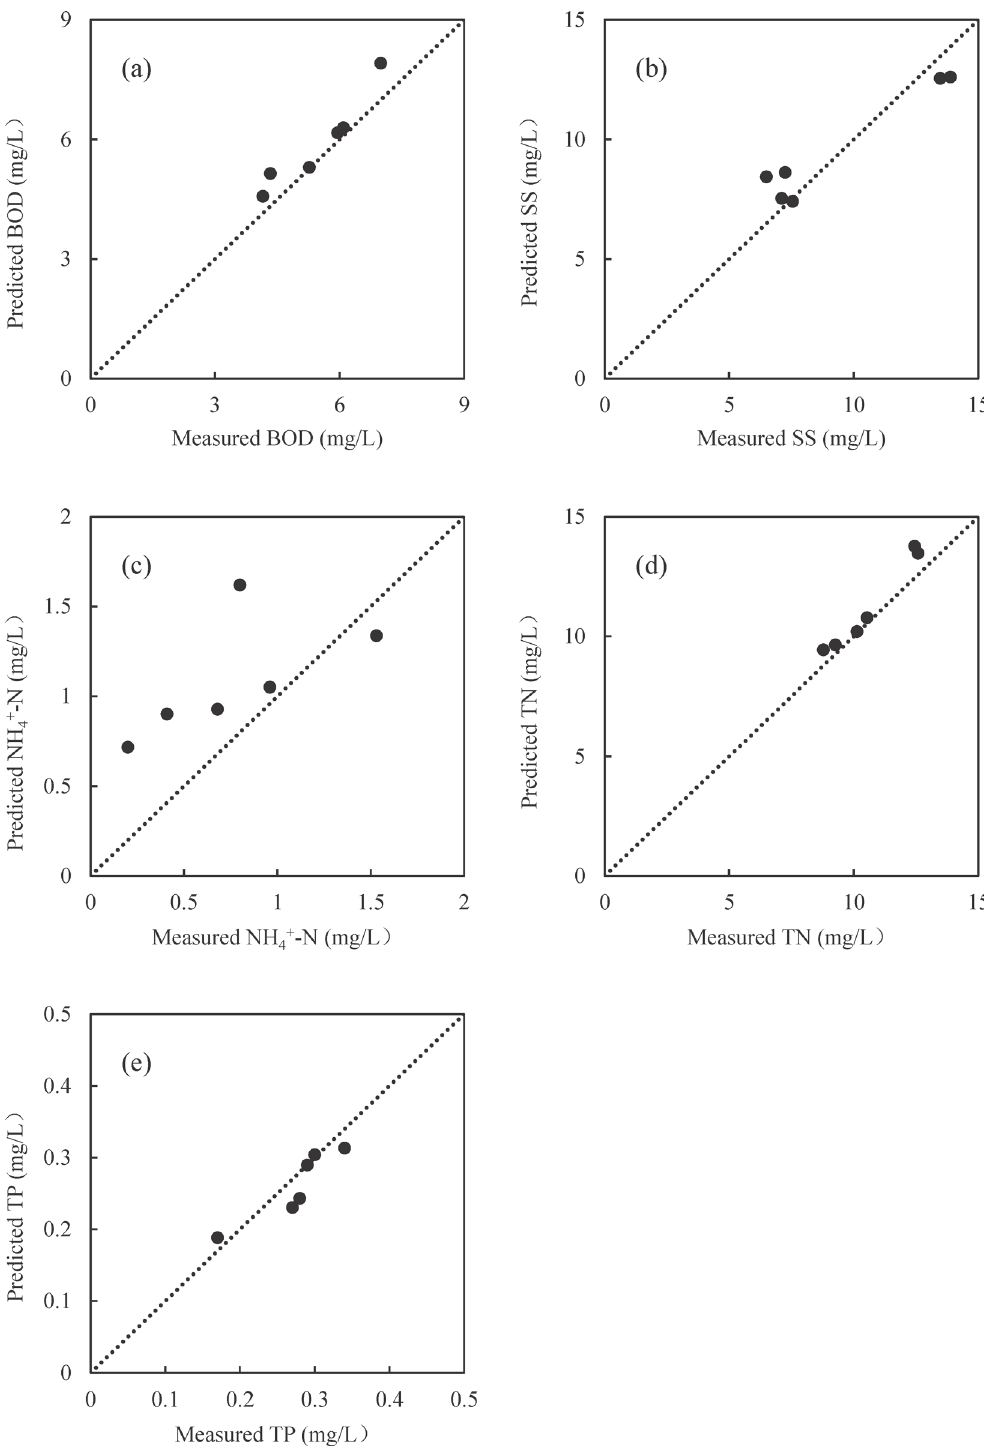
Fig 5. Plot of the modeled versus measured BOD (a), SS (b), NH 4 + -N (c), TN (d), and TP (e) concentration in effluent from the validation tests. The dashed line on each plot fits for the ideal “ y = x ” line which means the model perfectly fits the data set.